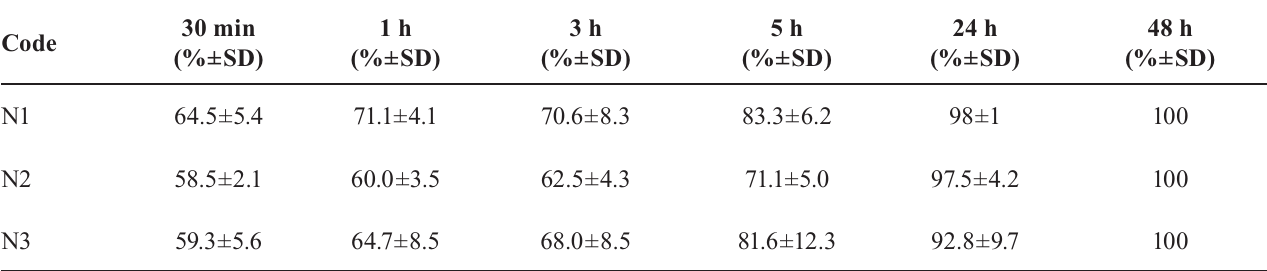
TABLE II - Release data of antibody conjugated nanoparticles